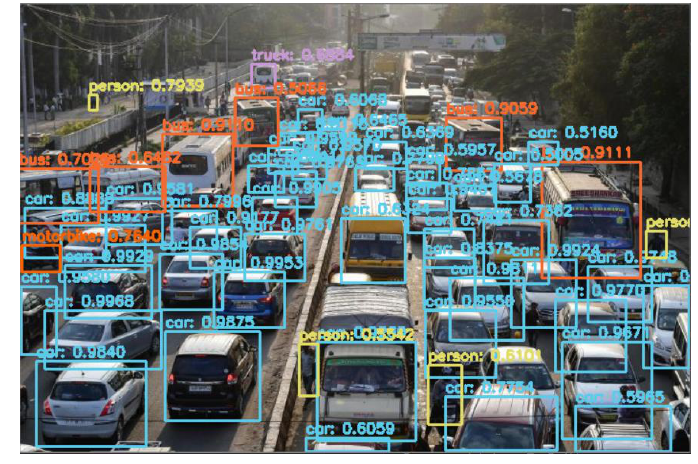
Figure 17. After detection.